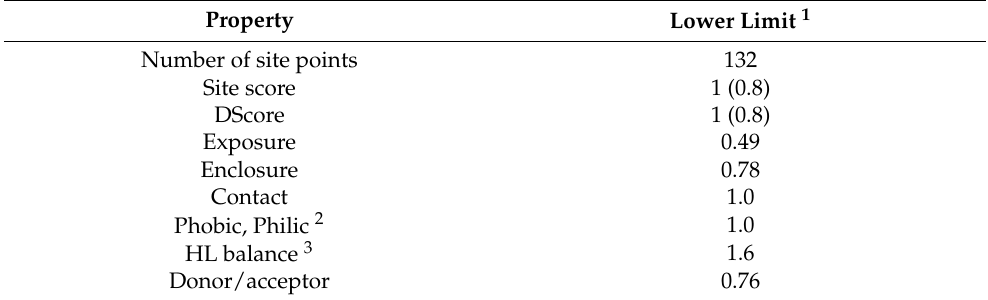
Table 1. Properties calculated by SiteMap [41] along with the average property score for a submicro- molar site. Data from